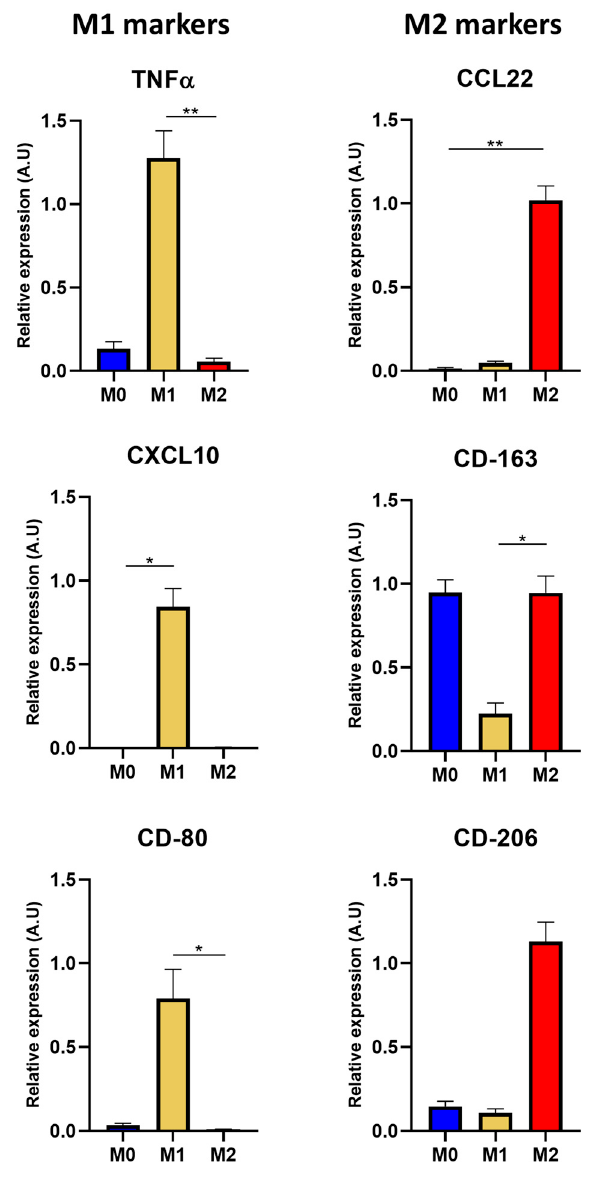
Figure 4. Gene expression of macrophage phenotypes. ARN extraction was performed 24 h after THP-1 polarization protocol. Mean relative gene expression of markers for M1 and M2 ( n = 3 for each protein marker, mean + SD, * p < 0.01; ** p < 0.001 with Kruskal–Wallis test).